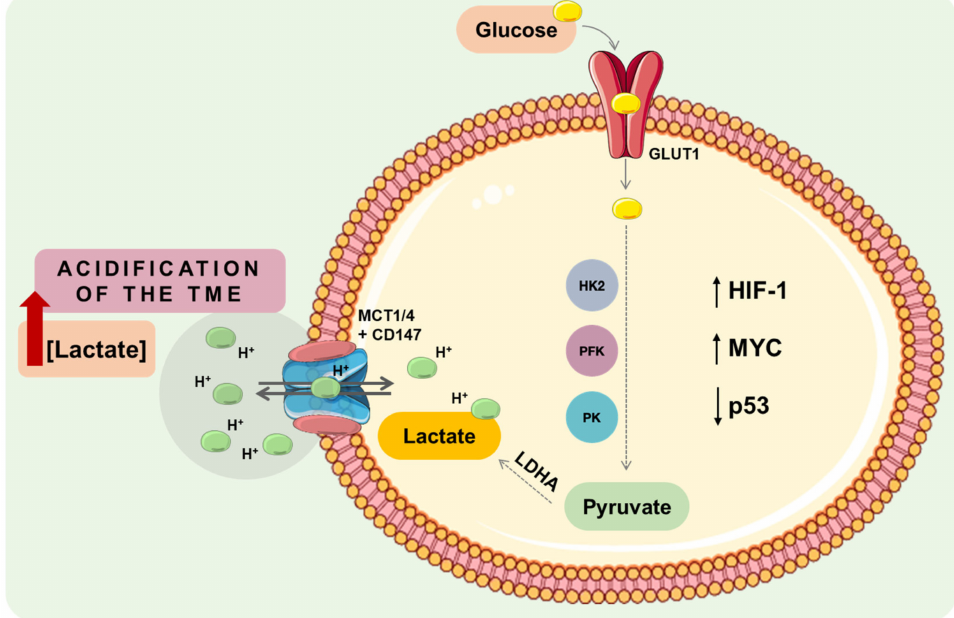
Figure 1. Cancer-associated metabolic alterations occurring with the Warburg phenotype. Intrinsic dysregulation of a range of different genes (oncogene activation, as MYC, or loss of tumour suppres- sor genes, as p53) leads to the activation of downstream pathways, which, ultimately, promote an increase of glucose consumption, glycolytic flux and lactate production. Altogether, the accumula- tion of extracellular lactate promotes the acidification of the tumour microenvironment, leading to cancer aggressiveness. CD147, cluster of differentiation 147; GLUT1, glucose transporter 1; HIF-1, hypoxia-inducible factor 1; HK2, hexokinase 2; LDHA, lactate dehydrogenase isoform A; MCT1/4, monocarboxylate transporter 1 or 4; p53, tumour protein 53; PFK, phosphofructokinase; PK, pyruvate kinase; TME, tumour